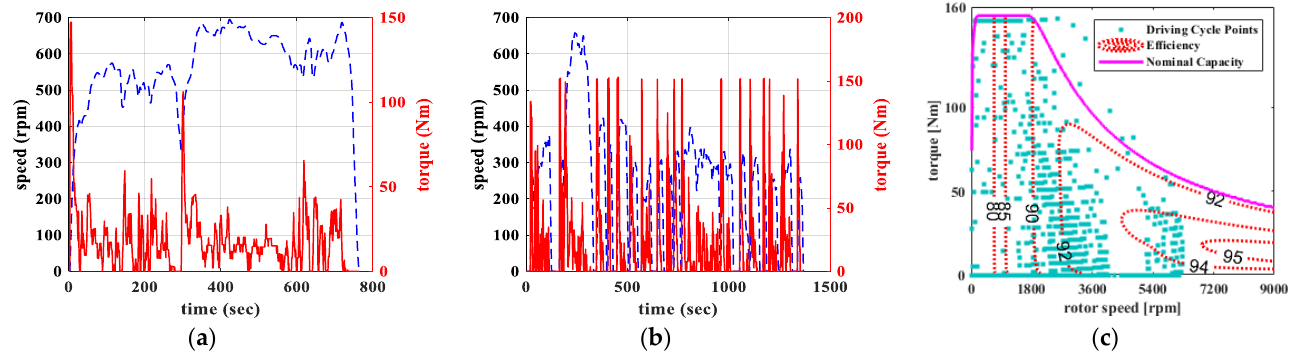
Figure 1. The torque-speed profiles of two driving cycles introduced for the optimization studies in different literature. The data of this plot has been collected from [23]. ( a ) Highway Fuel Economy Test (HWFET), ( b ) Urban Dynamometer Driving Schedule (UDDS), ( c ) Induction motor efficiency countor and the UDDS driving cycle operating points in the torque-speed envelope.